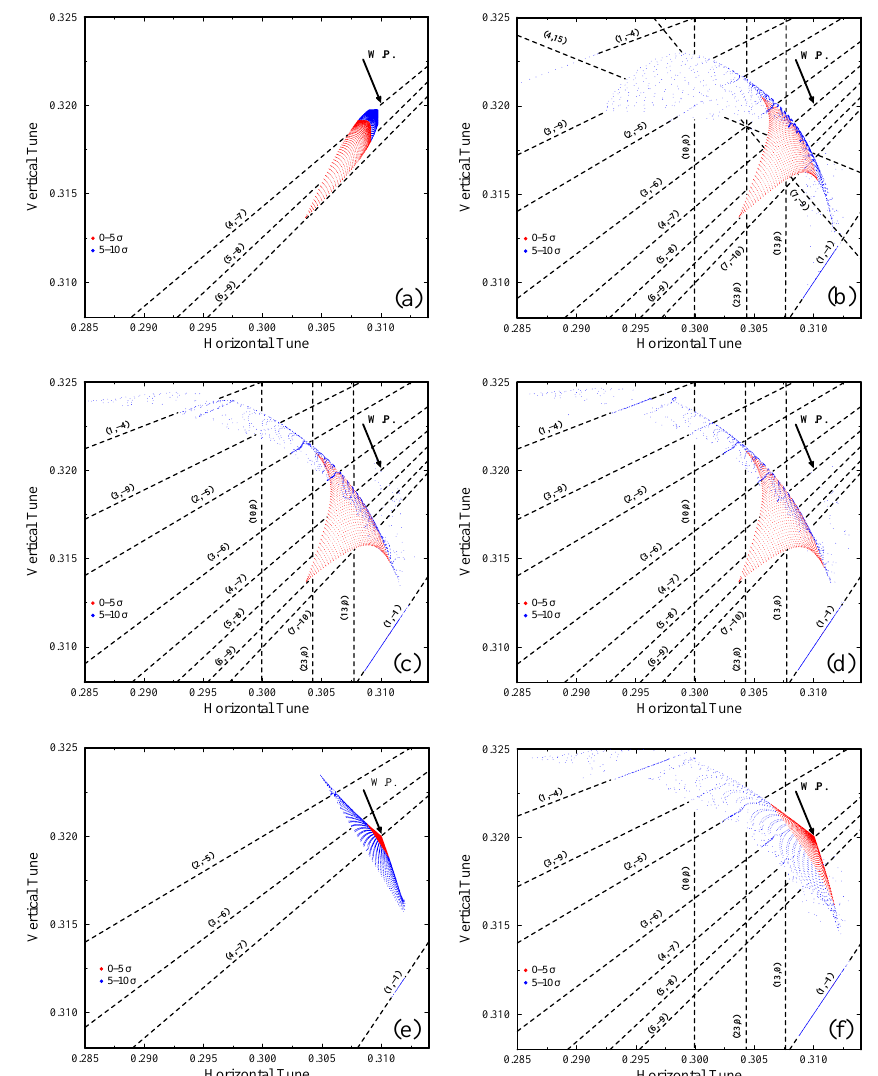
FIG. 1. (Color) Tune footprints obtained by tracking single particles over 1000 turns and subsequent frequency analysis. The red dots represent particles with initial transverse amplitudes up to 5 s x , y ; the blue dots show results for an extended range with initial amplitudes up to 10 s x , y . (a) Head-on collisions only, (b) head-on and long-range collisions, (c) head-on plus long-range collisions and FNAL triplet errors (one random seed), (d) head-on plus long-range collisions and KEK triplet errors (one random seed), (e) KEK triplet errors only (one random seed), and (f) long-range collisions and KEK triplet errors (one random seed), but no head-on collisions. An additional outcome of the frequency map analysis is displayed in the plots of Fig. 2, where we depict the variation of the betatron tunes j D Q j that occurs between the first and second sets of 500 turns, as a function of the starting amplitude [9,10]. The different colors correspond to different amounts of tune variation on a logarithmic scale, extending from j D Q j # 10 2 7 to j D Q j . 10 2 2 . The gray regions correspond to particles with a tune variation less than or equal to the precision of the tune calculation for this number of turns. Thus, their tune variation is consistent with no variation at all, and they may be considered as completely